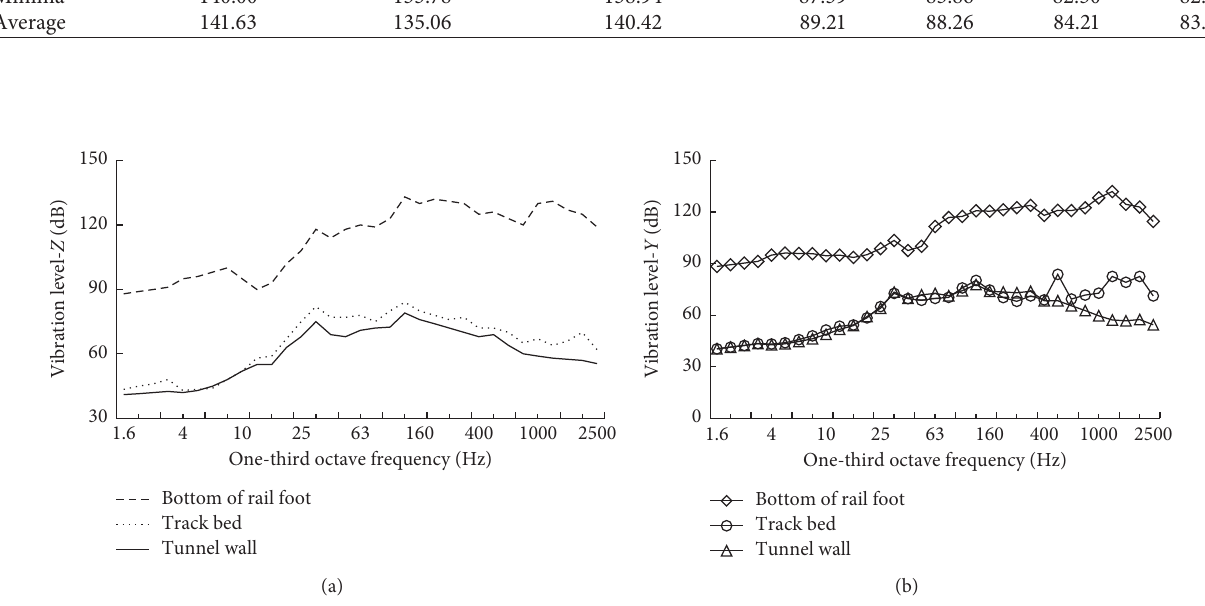
Figure 16: Vibration levels under one-third octave frequency in the tunnel: (a) Z direction; (b) Y